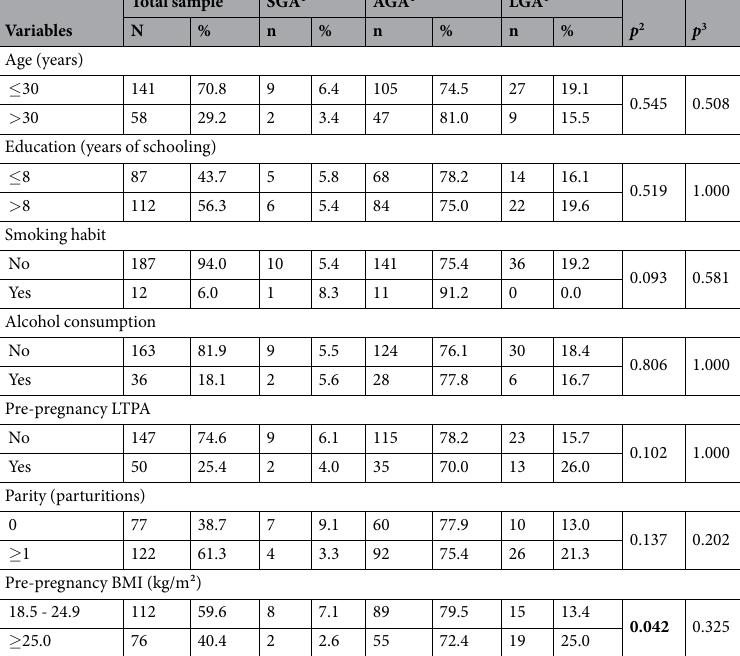
measures are correlated, accounts for different rates of change in the exposures and uses their longitudinal pre- dictions to evaluate the association with the outcome. The HDL-c rate of change during pregnancy was inversely associated with BW z-score and the delivery of LGA newborns. In a case-control study, Kramer et al . 33 also found that HDL-c concentrations were inversely asso- ciated with BW, i.e., women who delivered SGA infants had higher concentrations of HDL-c compared to women who delivered AGA infants. Misra et al . 14 evaluated the association between HDL-c concentrations at 10–14, 16–20, 22–26 and 32–36 gestational weeks and BW in 143 American women stratified for pre-pregnancy BMI. The authors found an inverse and statistically significant association at all time points, but only in overweight/ obese women. Misra et al . 14 also tested the influence of time-dependent changes in maternal serum HDL-c on BW and concluded that the trajectory of HDL-c change over time was not significantly associated with BW in any BMI category. In our theoretical model, maternal BMI was considered a possible confounder of the relation between mater- nal biomarkers (lipids, leptin and adiponectin) and BW since BMI is associated with both exposures and out- come. Previous publications also tested BMI as an effect modifier of the relation between maternal lipids and BW 14 . To test if BMI had the same effect in our sample, we carried out regression models including interaction terms between lipids, leptin and adiponectin (intercept and slope) with early pregnancy BMI. In contrast to Misra et al . 14 , we did not find significant interactions in crude or adjusted models between BMI with any of the maternal biomarkers on BW. The difference observed between the two studies can be attributed to BW classifications and the statistical procedure adopted. We observed that the rate of maternal LDL-c change during pregnancy was positively associated with BW z-score. Although some previous studies did not report this association 6, 14, 17 , Pecks et al . 34 found that the mean LDL-c concentrations were lower in mothers of term (n = 5) and preterm (n = 10) intrauterine growth restricted newborns compared with term (n = 5) and preterm (n = 10) controls, respectively. The association reached sta- tistical significance only between preterm groups. Merzouk et al . 35 found that obese women who gave birth to macrosomic newborns had significantly higher concentrations of LDL-c than those who delivered newborns with a healthy weight. We performed additional analyses to understand if the results of the present study remained the same when only the AGA subsample was considered. When LGA and SGA cases were simultaneously removed from the analysis, LDL-c and HDL-c lost the significant association with BW z-score. However, when only SGA cases were removed, HDL-c remained significantly associated. When only LGA cases were excluded, only LDL-c remained significantly associated with BW z-score. These analyses revealed that the associations between lipids and BW z-score were partially driven by the extremes of the BW distribution.